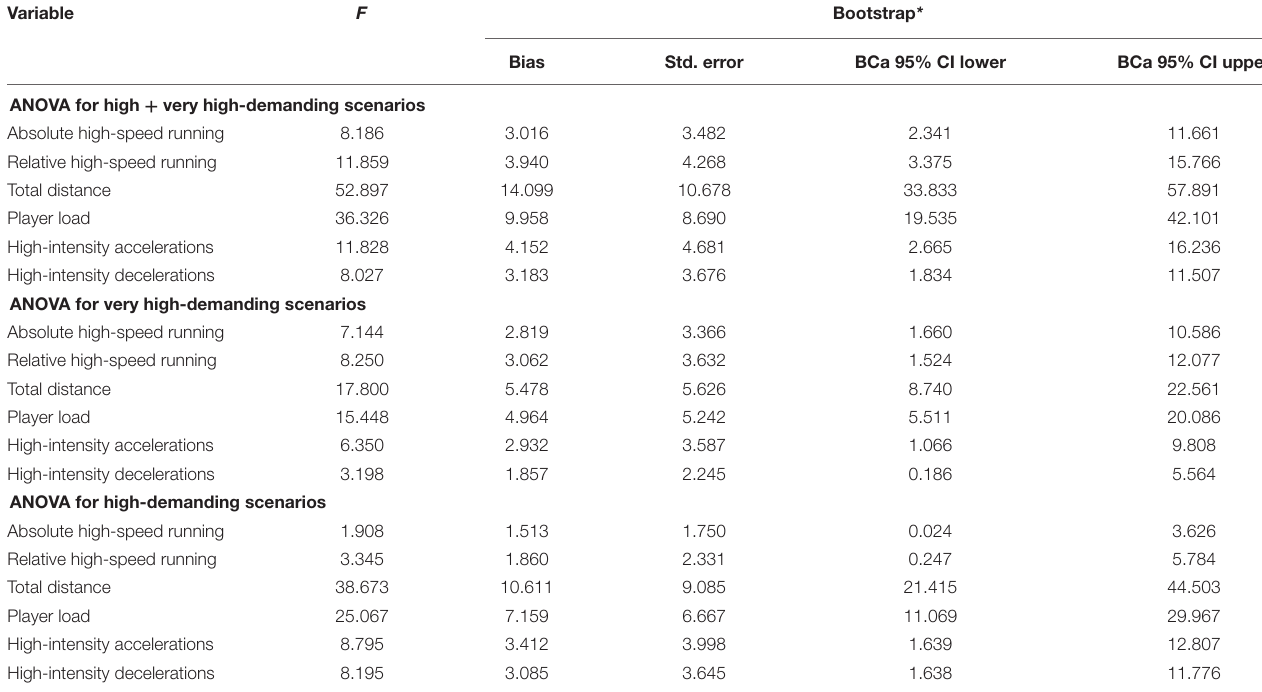
MD-X, session minus days before the game. TABLE 3 | Bootstrap ANOVA results for each scenario threshold.